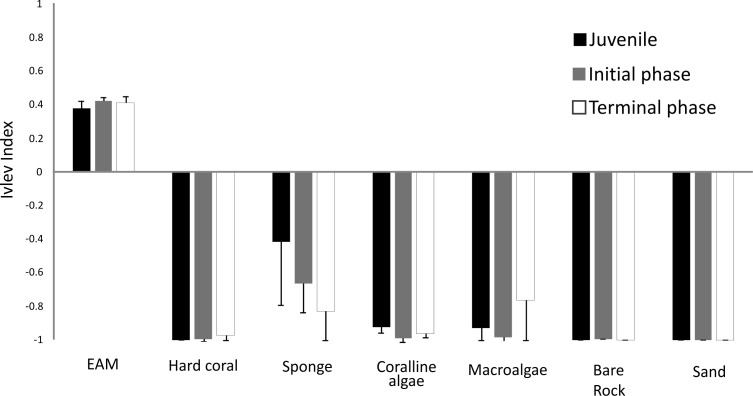
Ivlev’s electivity index of S. zelindae based off relative feeding rates and relative abundance of the benthos composition at foraging site.Bars in the figure represent 95% confidence intervals.